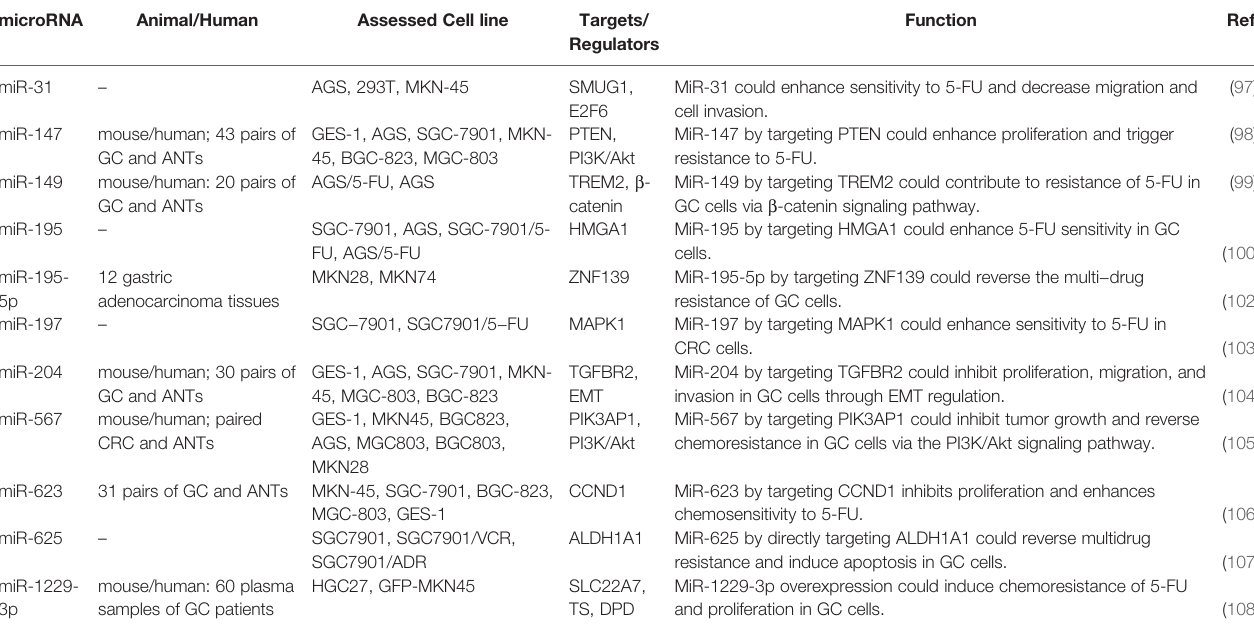
TABLE 3 | Impact of miRNAs in the response of gastric cancer to 5-FU (ANT, adjacent normal tissue).